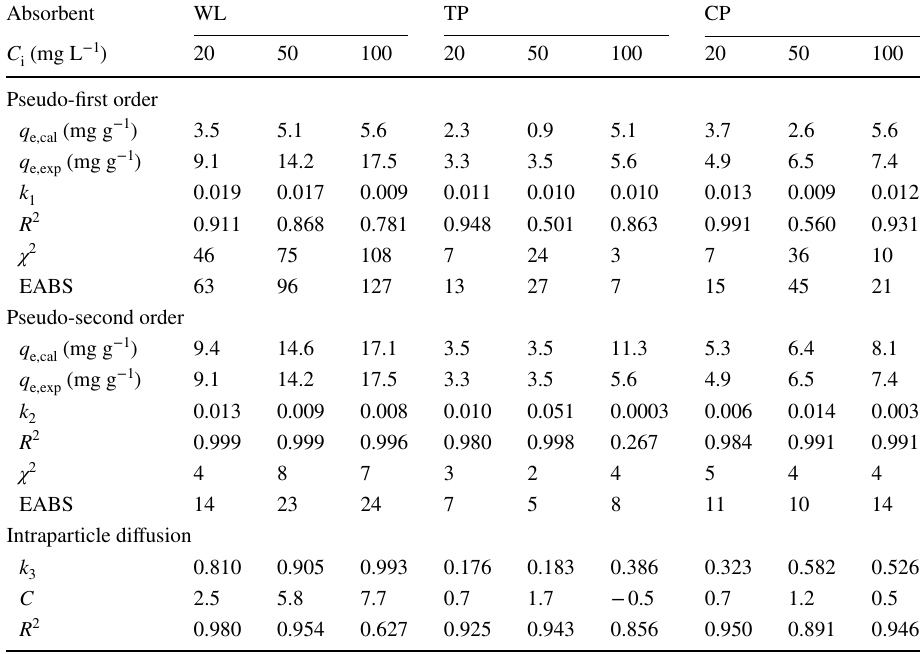
Table 2 Summary of the kinetic parameters